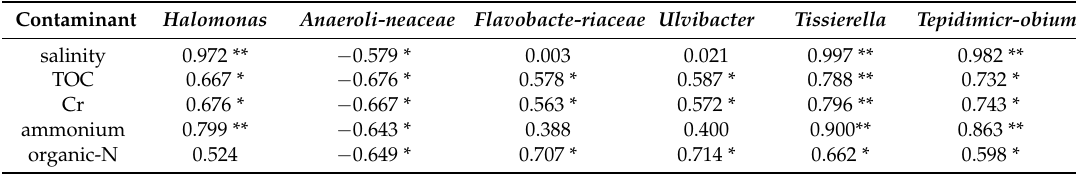
Table 3. Spearman rank correlation analysis of the soil contaminants with the dominant